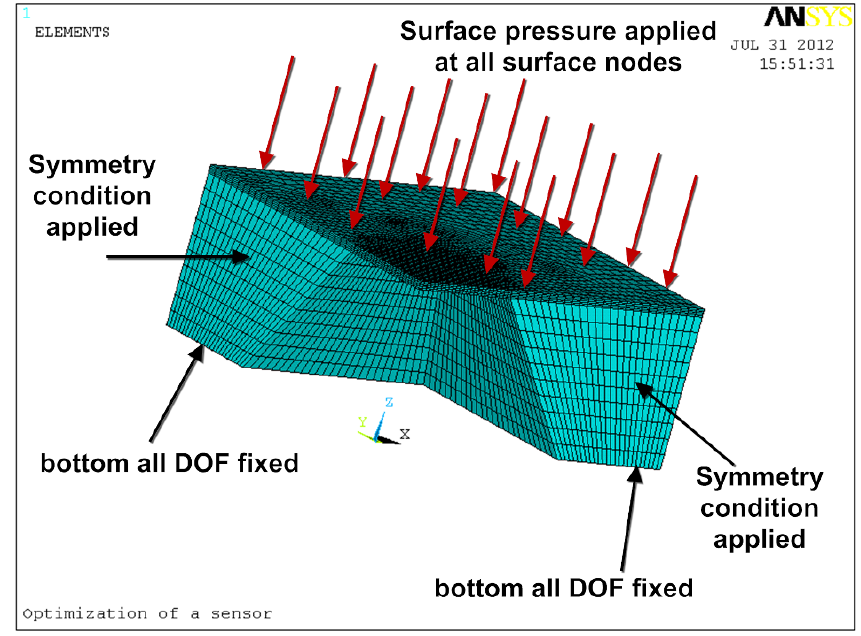
Figure 3. Meshed ANSYS model with the applied boundary